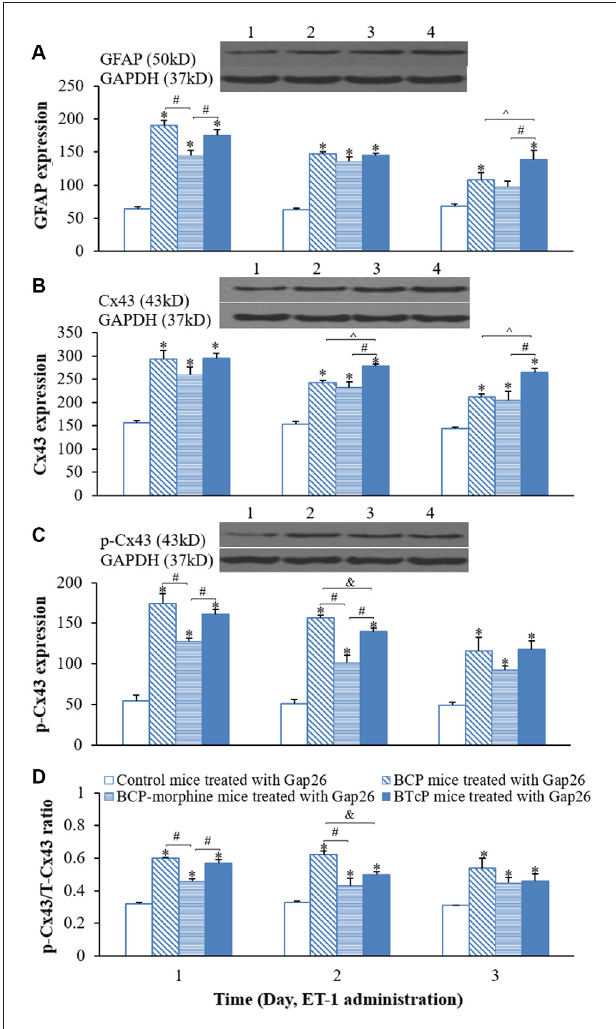
FIGURE 5 | Effects of Gap26 on protein expressions of GFAP (A) , Cx43 (B) , p-Cx43 (C) and the ratio of p-CX43/T-Cx43 (D) in normal, BCP, BCP-morphine and BTcP mice. The bands of Western blotting in (A–C) : (1) protein extracts from the tissues of spinal cord in a representative control mice treated with Gap26; (2) protein extracts from the tissues of spinal cord in a representative BCP mice treated with Gap26; (3) protein extracts from the tissues of spinal cord in a representative BCP-morphine mice treated with Gap26; and (4) protein extracts from the tissues of spinal cord in a representative BTcP mice treated with Gap26. GFAP, Cx43 and p-Cx43 were analyzed by Western blotting and the ratio of p-CX43/T-Cx43 was calculated from phosphonated Cx43 and total Cx43. Gap 26 was administrated by intrathecal injection at 5 mg/kg/day, once a day for 3 days (PIDs 16–18). Five mice were used for each group. ∗ P < 0.05, vs. control mice; # P < 0.05, vs. BCP-morphine mice; ∧ P < 0.05, vs. BCP mice; & P < 0.05, vs. BTcP